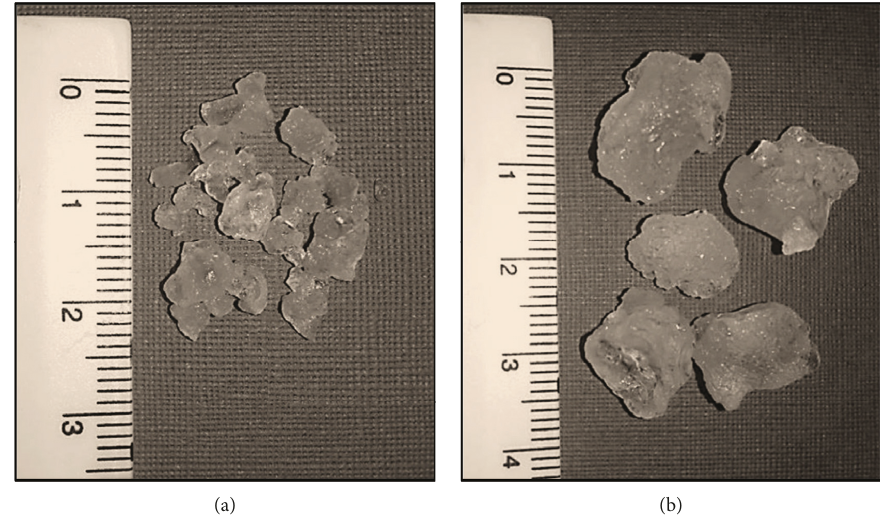
Figure 1: Water Kefir grains: Colony 1 (a) and Colony 2 (b).